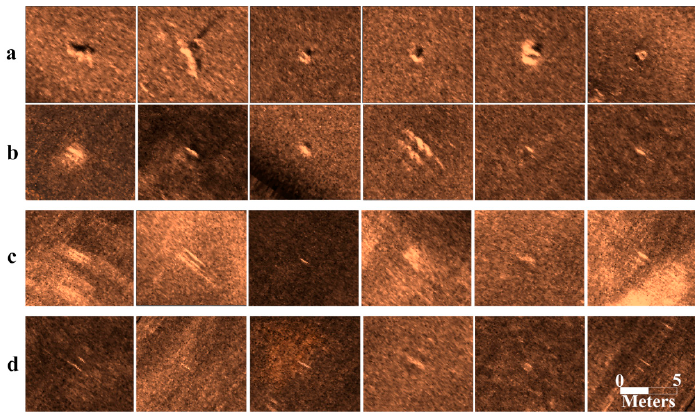
Figure 6. Examples of true positive detections that have been made by: ( a , b ) all models; ( c ) Models 3 and 4 employing component analysis and component selection and ( d ) exclusively Model 4, which applies the proposed method using ICA.